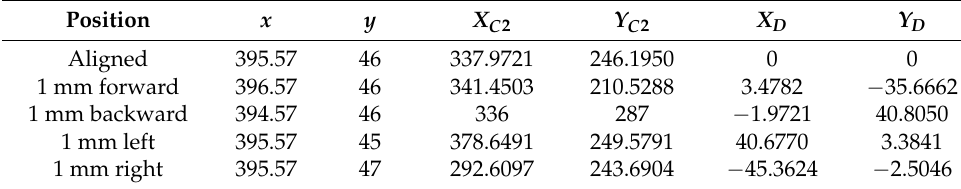
Table 5. Measurement data for No. 12 screw